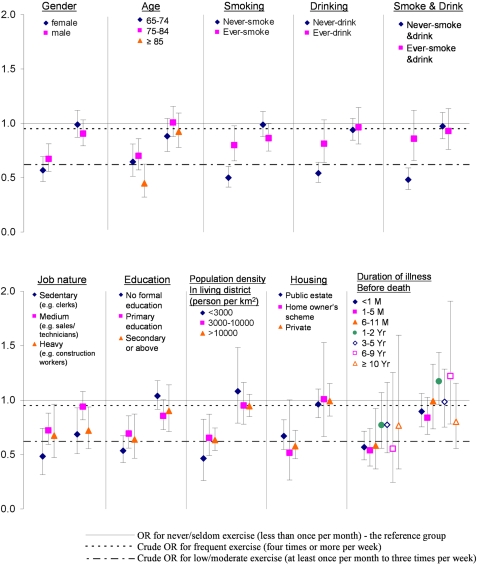
Group specific odds ratios for association between death during influenza epidemic and (i) low/moderate exercise (left) and (ii) frequent exercise (right) relative to never/seldom exercise stratified by social, demographic and life-style factors for age ≥65.